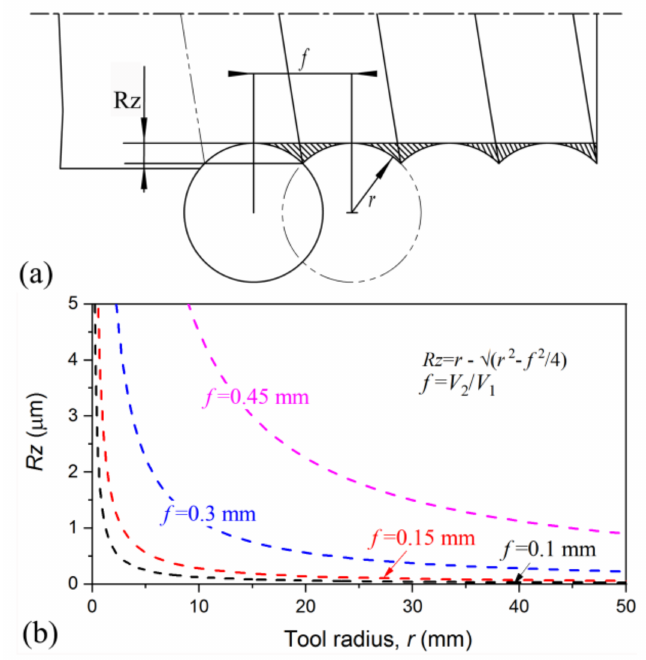
Figure 13. Schematic illustration of the surface roughening during processing by tool with radius r ( a ) and the variation of roughness as a function of r for different feed rates ( b